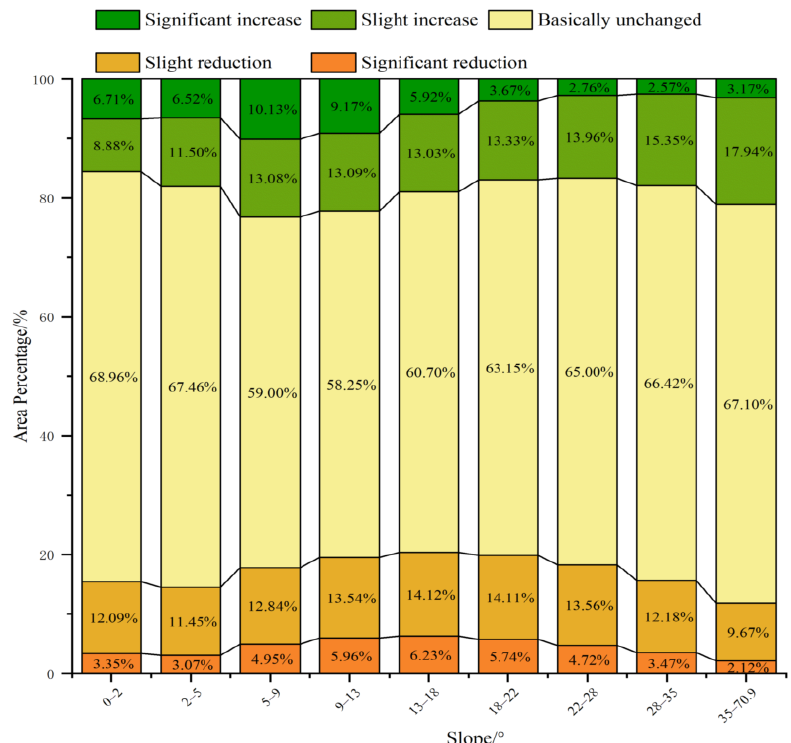
Figure 7. Vegetation cover change statistics of different slopes in the Three North Protection Forest Project area.